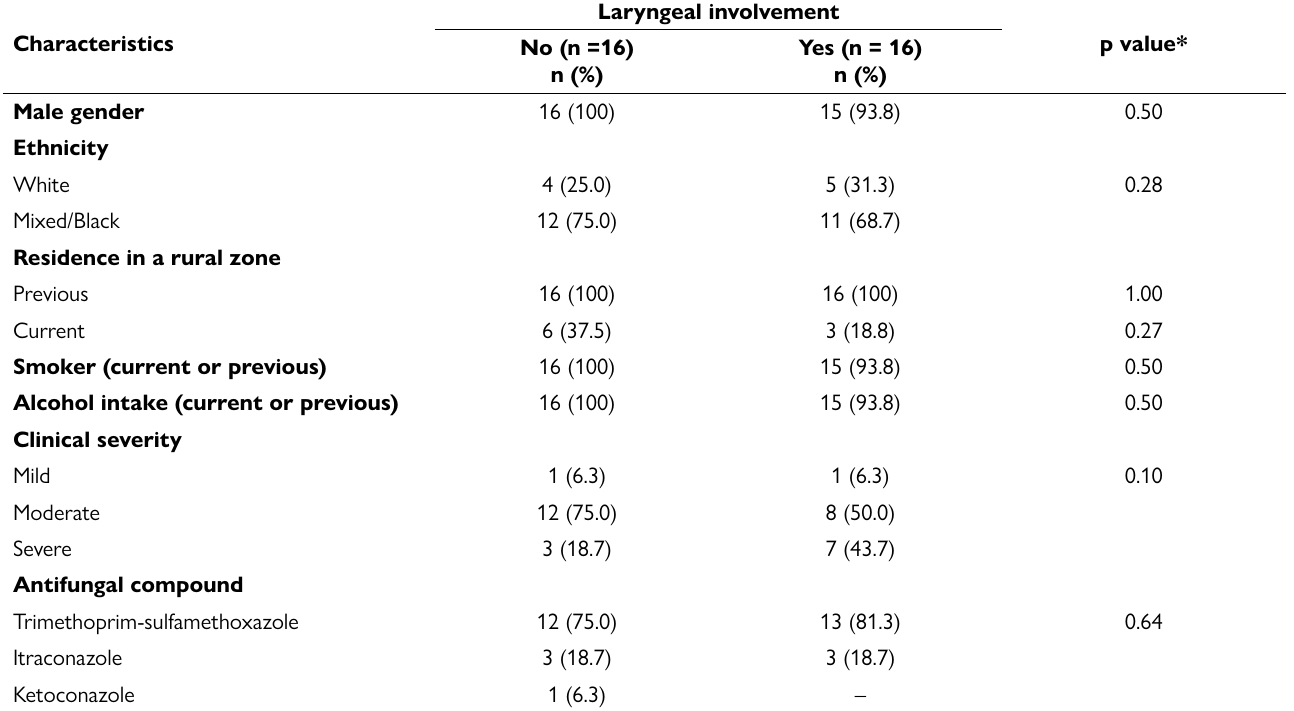
Table 1. Baseline characteristics of the paracoccidioidomycosis patients with (n = 16) and without (n = 16) laryngeal involvement.